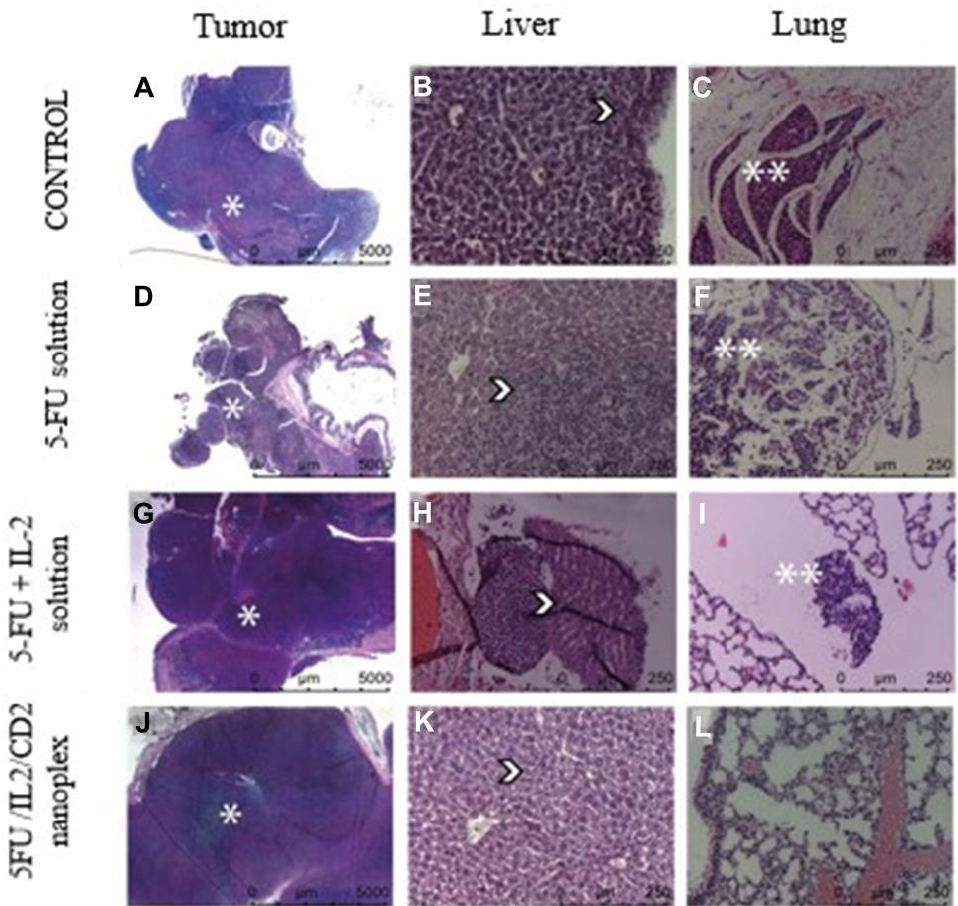
18 of 25 Figure 13. Colorectal tumor ( A , D , G , J ), liver ( B , E , H , K ) and lung ( C , F , I , L ) micrographs of the groups treated with PBS, 5-FU solution, 5-FU+IL-2 solution, and 5FU/IL2/CD2 nanoplex. Arrow indicates orthotopic tumor tissue and peritumoral tissue (*), metastatic tumor tissue located in the liver parenchyma ( ), and metastatic tumor tissue located in the lung parenchyma (**). There was no significant difference in the hepatic metastasis area between the PBS- treated group and the groups that received the 5-FU solution, 5-FU+IL-2 solution and 5FU/IL2/CD2 nanoplex (Figure 14a). However, when metastatic foci in the lung were an- alyzed, the metastatic focus area was significantly reduced in the 5FU/IL2/CD nanoplex applied group compared with the PBS applied group (Figure 14b). Figure 14. The metastatic areas (*) in liver ( a ), and lung ( b ), in treatment groups treated with PBS, 5-FU solution, 5-FU+IL-2 solution and 5FU/IL2/CD2 nanoplex (* p < 0.05). 4. Discussion 4.1. Cell Culture Studies 4.1.1. xCELLigence Real-Time Cell Analysis Real-time cell viability analysis was used to determine the appropriate concentration and appropriate treatment time in real time by evaluating the time-dependent effect of active substances on cells [36,37]. Real-time cell viability analysis was performed with the IC 50 dose of 5-FU in CT26 cells calculated with the data obtained from 2D cell culture studies. When the findings of the real-time cell proliferation assay were compared with the control group, the nanoplexes prepared with each of the three CD derivatives signifi- cantly reduced cell proliferation at the end of the 48th hour. However, no significant dif- ference was observed when nanoplex formulations were compared with solutions con- taining 5-FU. In conventional cell culture, in our previous study, we observed that the 5FU/IL2/CD1 nanoplex was statistically significantly more cytotoxic than 5-FU solution and 5-FU+IL-2 solution at the end of 24 and 48 h [31]. 4.1.2. Antitumoral Activity of CD Nanoplexes on 3D Spheroid Tumor Culture After conventional cell culture studies, the efficiencies of the formulations were de- termined in the 3D cell culture method. The tumor model was successfully formed [38]. Furthermore, when the findings presented in the study were compared with the results of the conventional 2D cell culture (viability at 20% for nanoplexes), the effect of nano- plexes on cell proliferation was less in 3D cell culture (viability at 40% for nanoplexes). This was an expected result, given the structure of the in vitro 3D spheroid. In conven- tional cell culture studies, cells are planted as a monolayer on cell culture plates, and it is